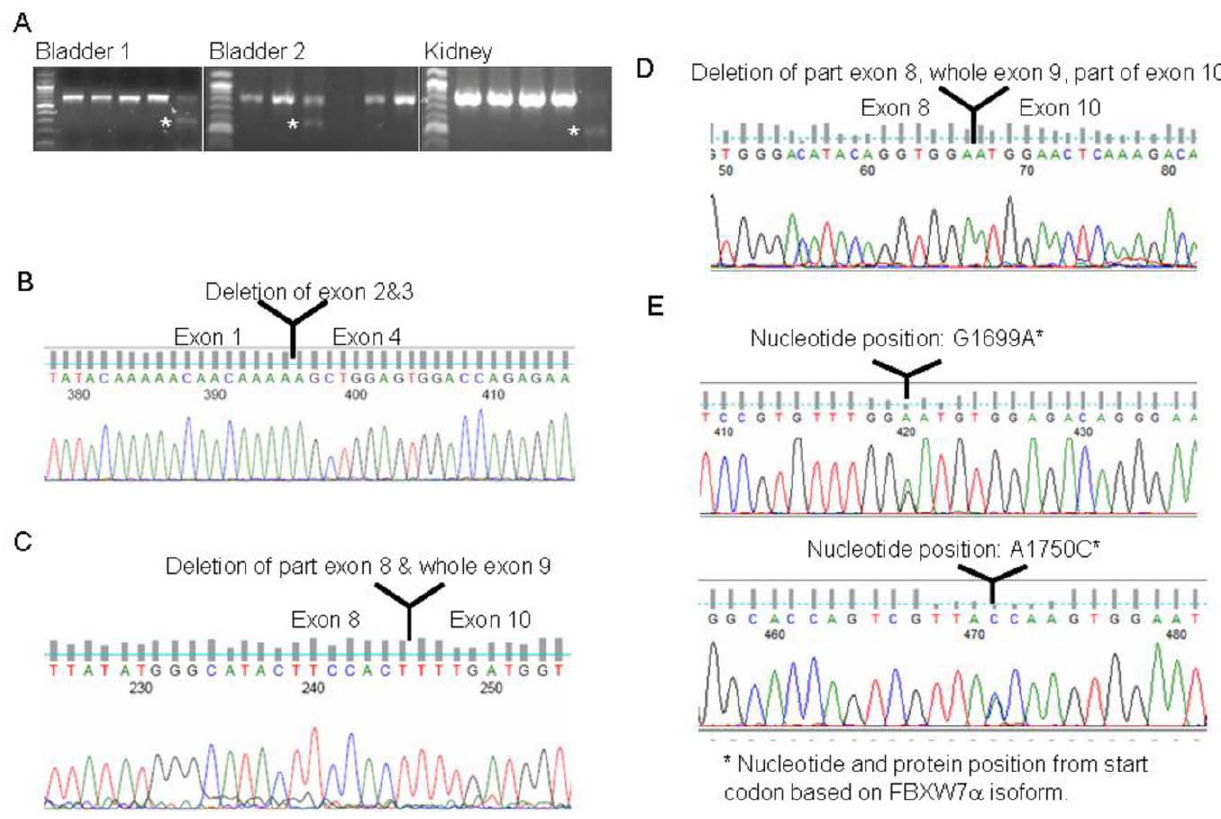
Figure 5. Mutational analysis of FBXW7 in primary prostate, bladder, and kidney cancers from the Chinese patients. (A) RT-PCR analysis of FBXW7 , RT–PCR products containing deletions are indicated by asterisk. (B–D) sequencing confirmed the deletion in two bladder cancers (B and C), and a kidney cancer (D). (E) Representative sequence traces showing the mutations of FBXW7 .